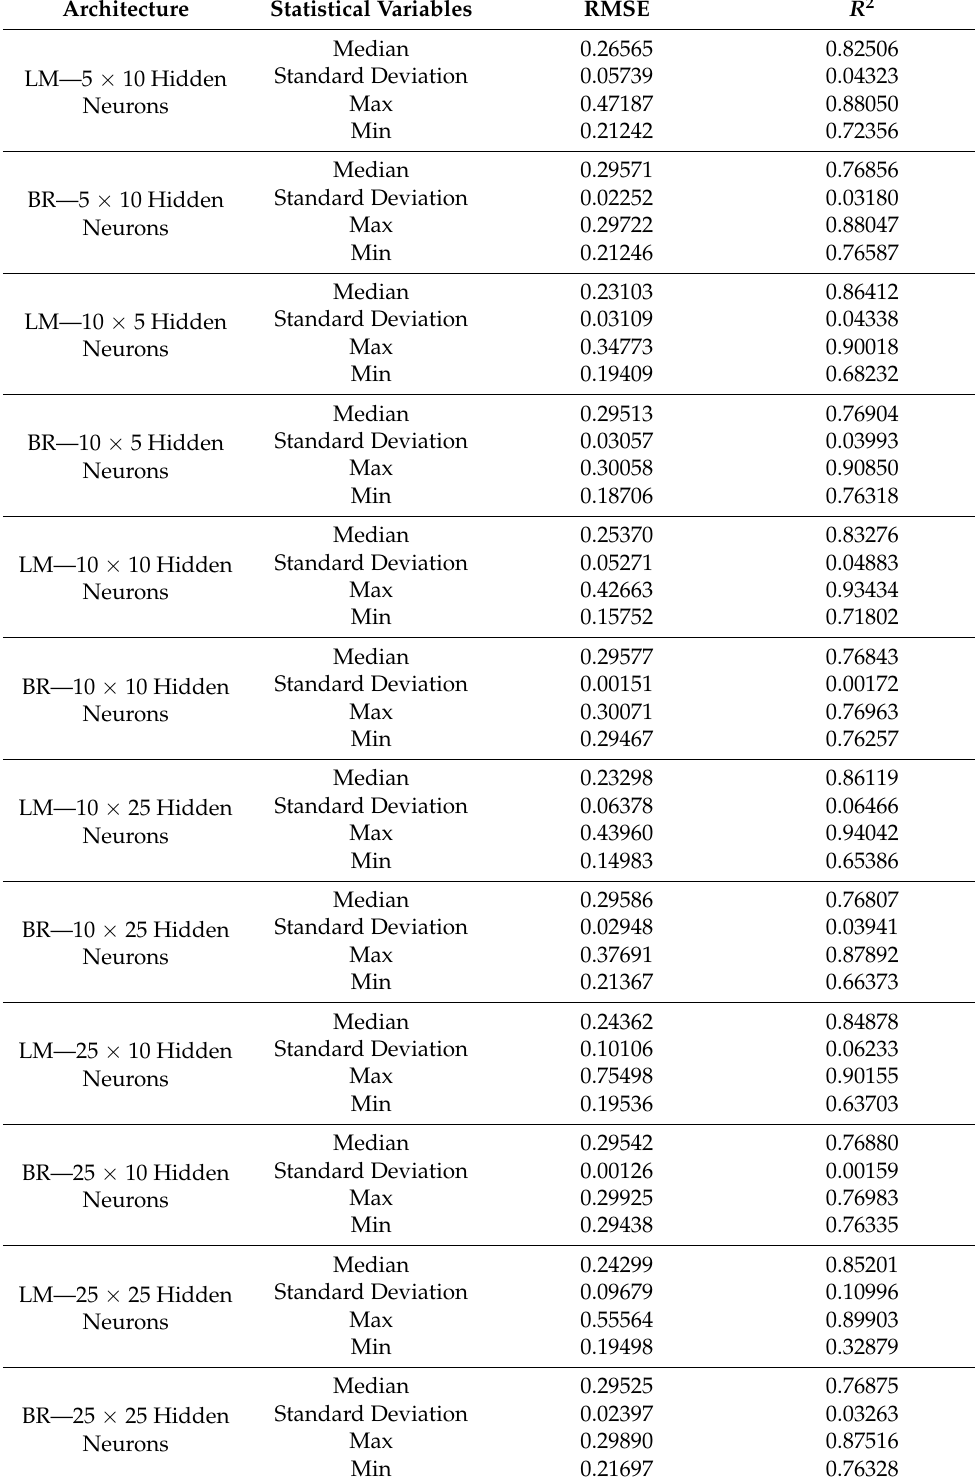
Table 5. Results summary for the structural FFNN2 with two hidden